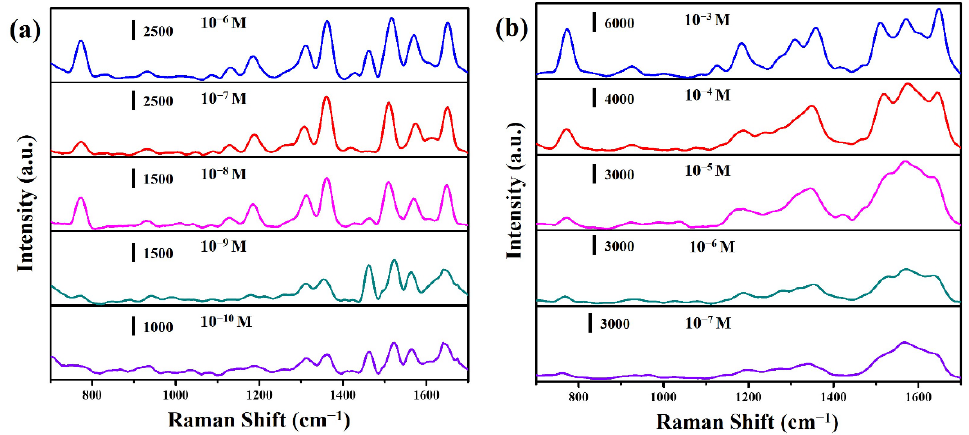
Figure 9. SERS spectra of ( a ) amoxicillin and ( b ) 5-fluorouracil at different concentrations were obtained from CuO@RF@Ag nanowires.